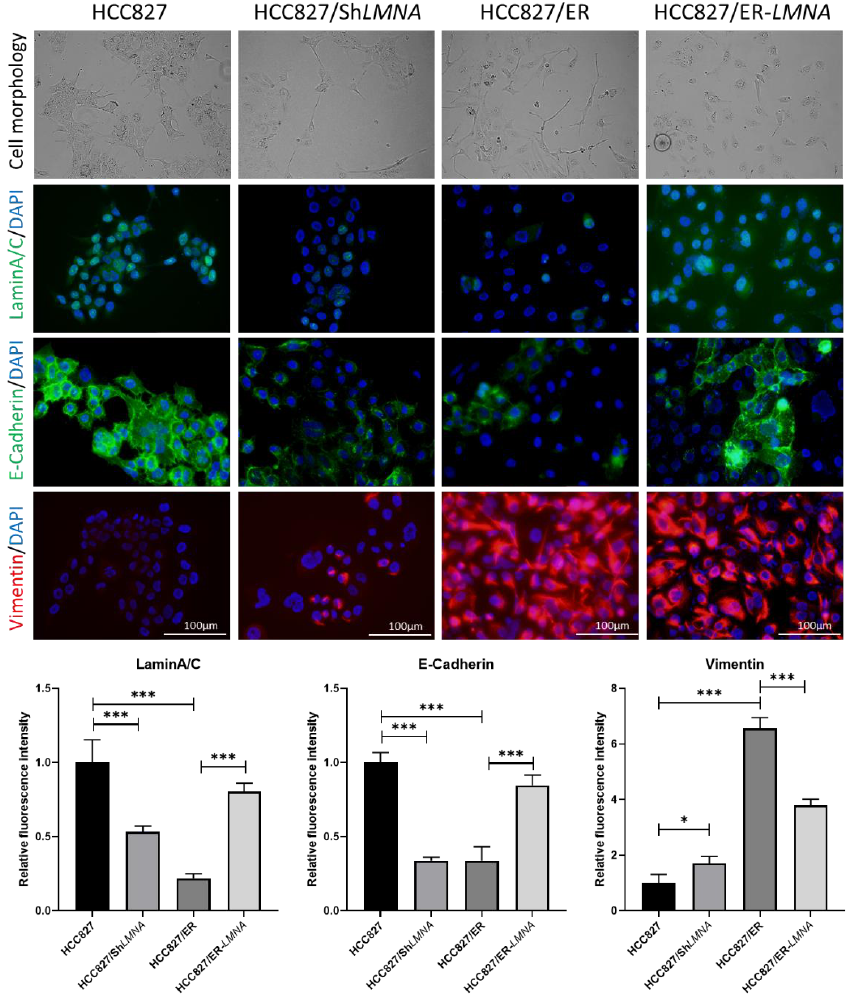
Figure 5. LMNA regulation of EMT in erlotinib-acquired resistant lung adenocarcinoma cells; mor- phological changes from an epithelial phenotype to a spindle-shaped EMT-like morphology in HCC827 cells after knockdown of LMNA . EMT-like morphology in HCC827/ER cells was reversed by overexpression of LMNA . Levels of laminA/C (green), E-cadherin (green), and vimentin (red) were determined by immunofluorescence assay. Nuclei were visualized using DAPI staining (blue). Data are presented mean ± SD from three independent experiments. Significant differences are in- dicated as follows: Student’s t -test, * p < 0.05, *** p < 0.001.